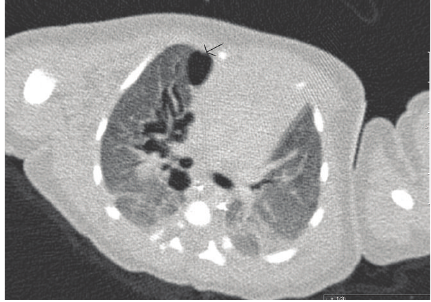
Figure 4: Representative slice from CT scan shows loculated pneumomediastinum (arrow) and multiple branching lucencies in a perivascular distribution, compatible with